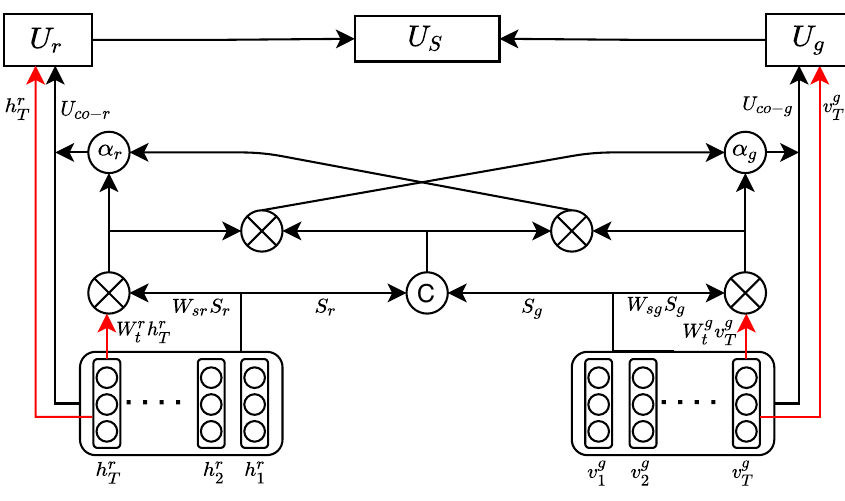
Figure 2. Details of the parallel co-attention